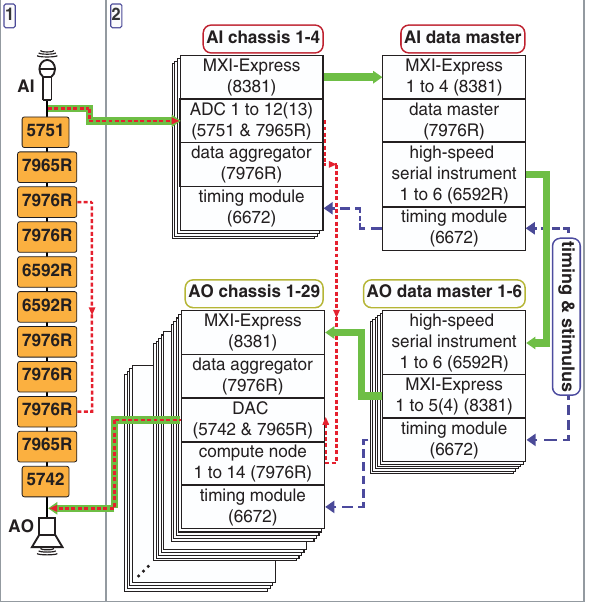
FIG. 13. Device path from analog input to analog output (panel 1) and Low-level view of the WaveLab system architecture (panel 2). Green and blue arrows represent data transfer and trigger signals, respectively. The numbers in parentheses and in the device path correspond to the National Instruments module names. The hardware components and device path used for the 1D experiments demonstrated in this study are denoted by red dashed